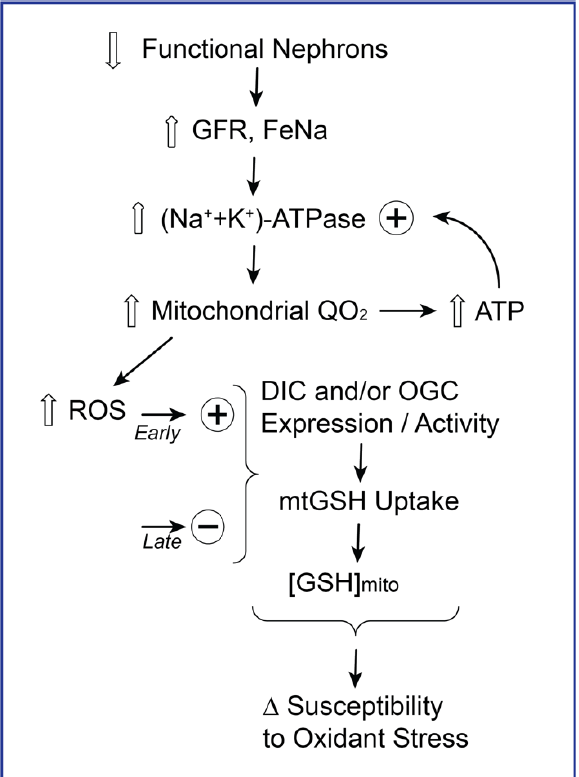
Figure 3. Summary scheme showing impact of compensatory renal hypertrophy (CRH) on renal PT cell mitochondrial function and redox status. The initial compensatory response to a loss in the number of functional nephrons leads to an increase in the glomerular filtration rate (GFR) and fractional sodium excretion (FeNa). These changes, in turn, activate the plasma membrane (Na + + K + )-ATPase, which increases cellular ATP consumption. As a consequence, the mitochondrial respiration rate (QO 2 ) increases. The persistence of these changes ultimately results in increased levels of reactive oxygen species (ROS), which impact mitochondrial redox status. Initially, compen- satory increases are observed in antioxidants, such as glutathione (GSH). However, with contin- ued hypermetabolism in the mitochondria, oxidant stress and increased cell injury occurs. + = stimulated; − = inhibited.